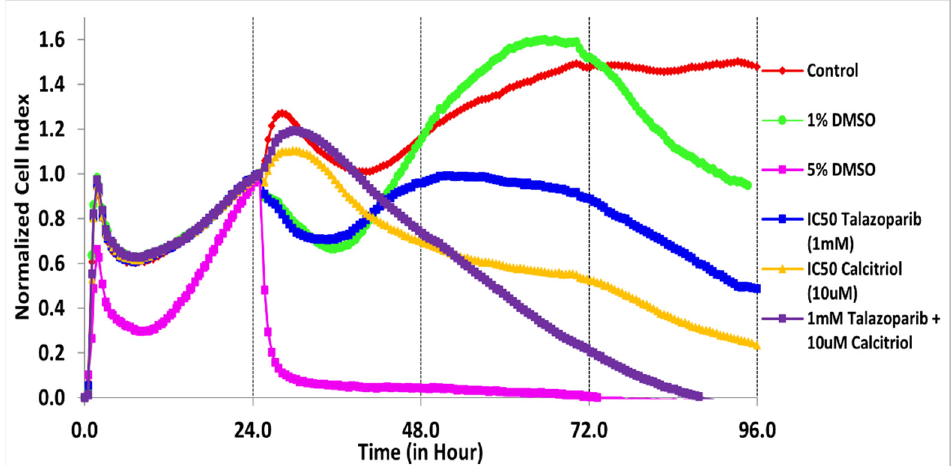
Figure 2. Antiproliferative effect of talazoparib and calcitriol on MDA − MB − 468 cells. Cells were seeded overnight to reach the log phase, then incubated with IC 50 of 1 mM talazoparib and 10 µM calcitriol for 96 h. Data are represented as the mean ± SD ( n = 3). The drugs were added after 24 h. The green color line is the vehicle control (1% DMSO) and the pink color line is the positive control (5% DMSO). Raw data can be found in Supplementary File S2. Table 1. The IC 50 concentrations on the BT − 20 cell line and the relevant time